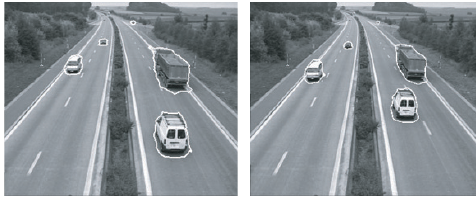
Figure 3: Highway: final contours in white.